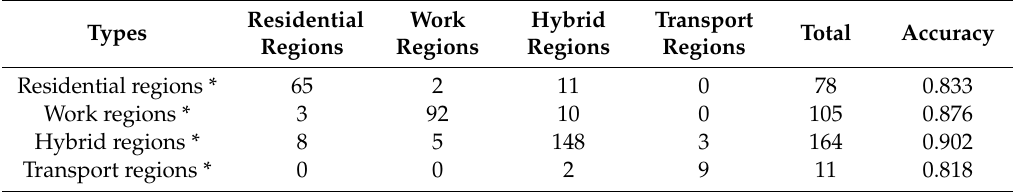
Table 4. Confusion matrix of jobs–housing-based classification.